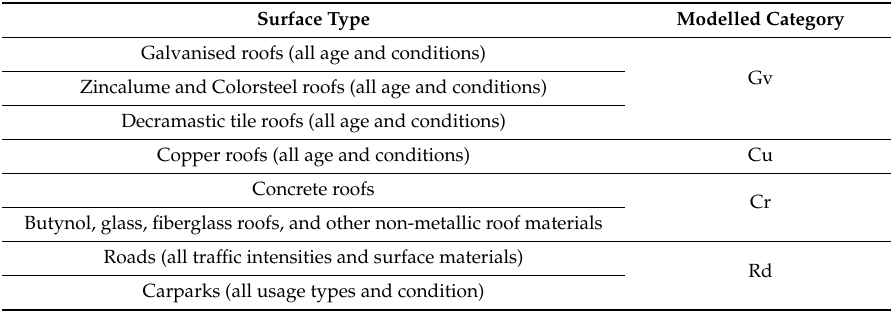
Table A3. Category allocation for Okeover surface types on the basis of calibrated model coe ffi cients (see Appendix